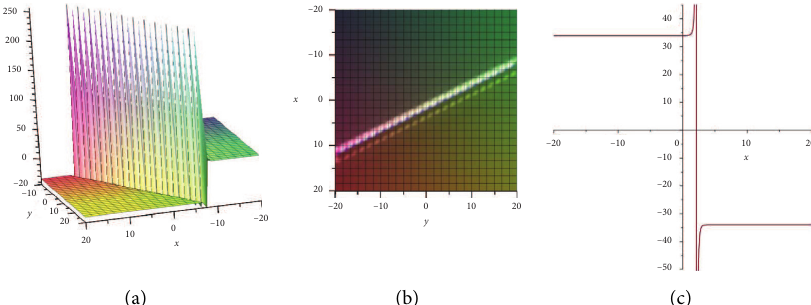
Figure 3: Trigonometric function solution (28) for equation (1) with l � 1 , m � 2 , c � 1 , λ � 1 , μ � 3 , a (a) Perspective view of the real part of the wave. (b) The overhead view of the wave. (c) The wave propagation pattern of the wave along the x axis with y � 1.